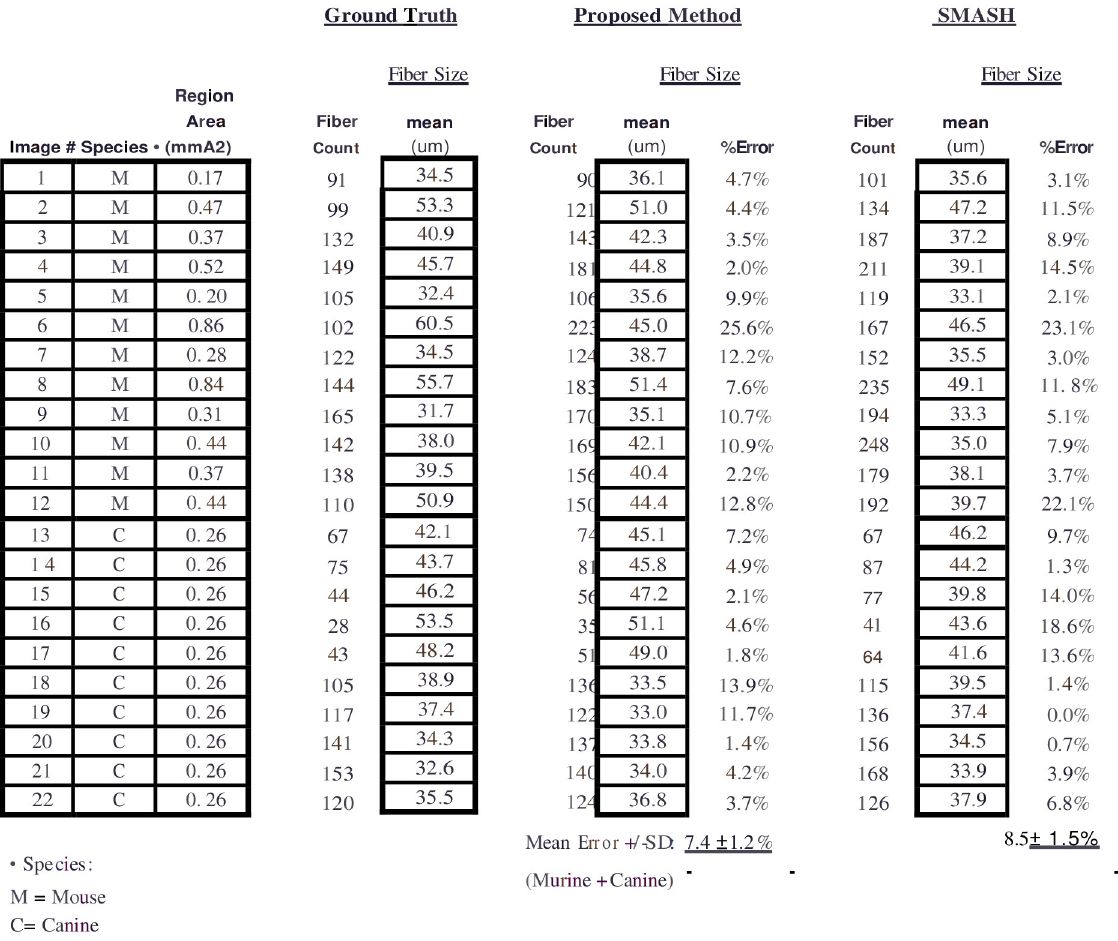
Fig 2. Comparison of manual tracing method (Ground truth), MyoSAT, and SMASH to analyze 12 murine (TA) and 10 canine (CAL) muscle cross-section images. (22 Images total) % Error = percent difference of the minimum Feret diameter from the ground truth.